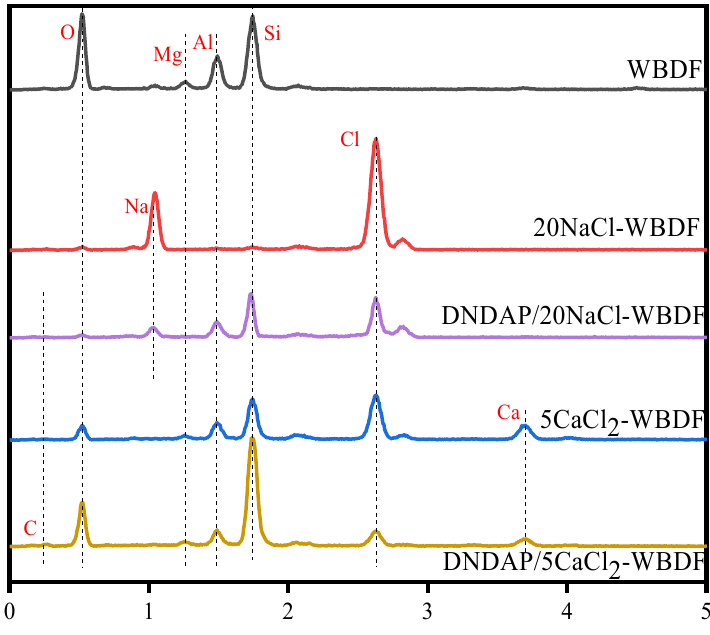
Figure 8. EDS element analysis of filter cakes.